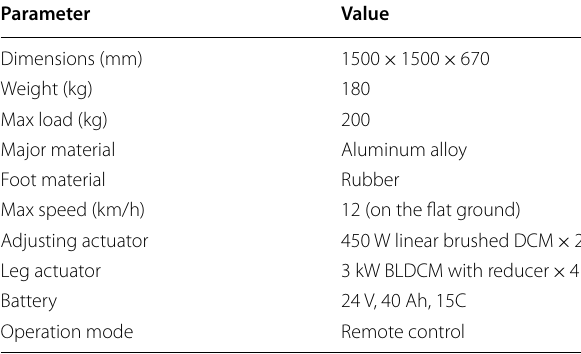
Table 6 Prototype